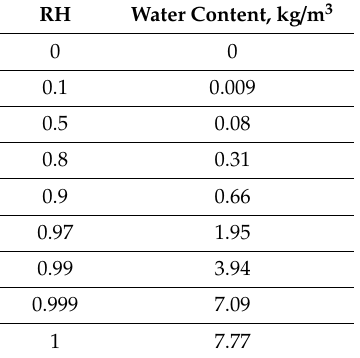
Table A4. Moisture storage function.